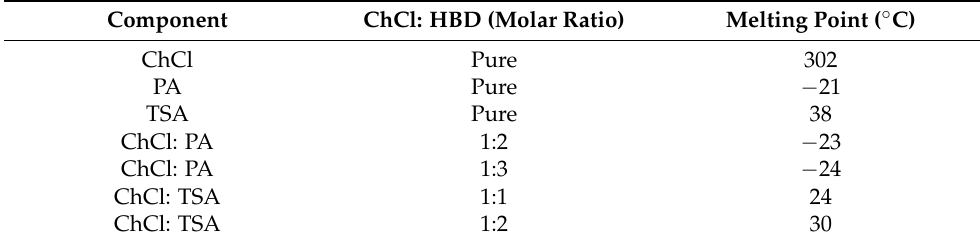
Table 2. Melting points of